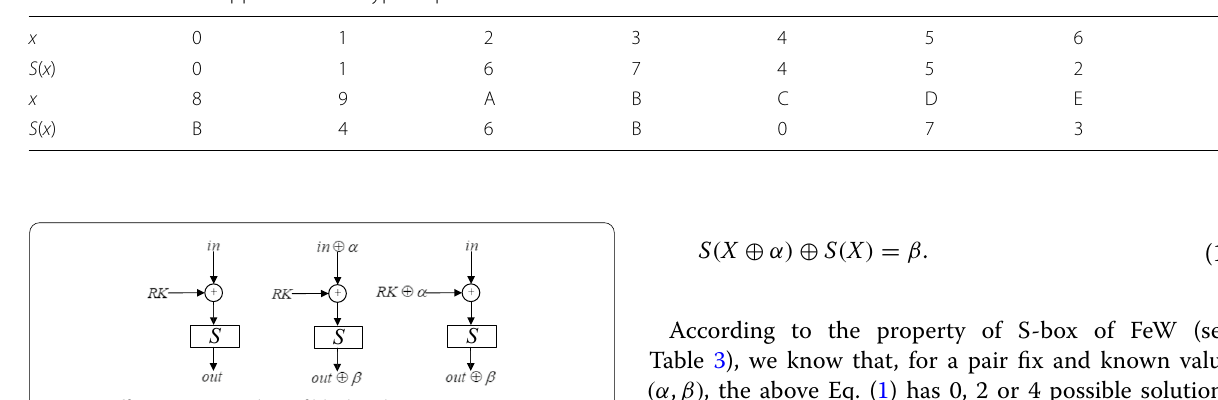
Fig. 3 Difference across S-box of block